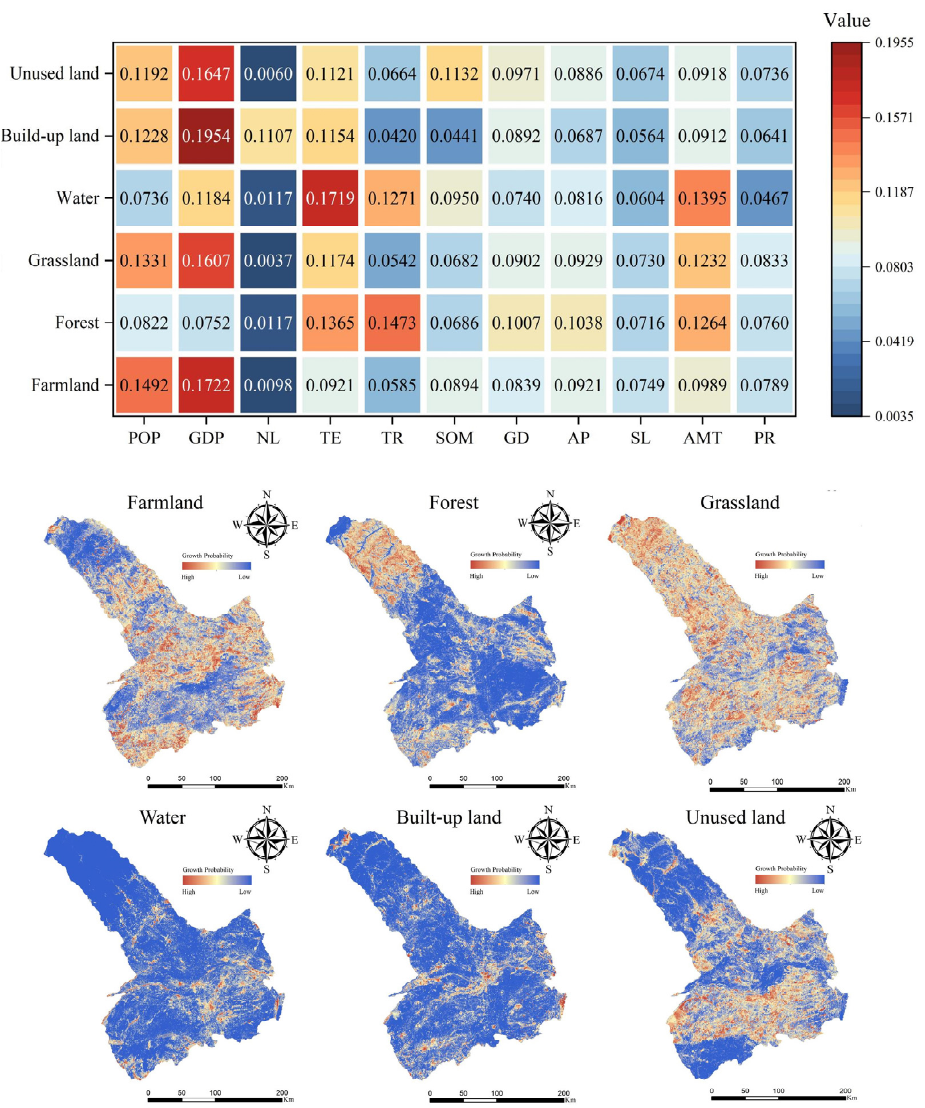
Figure 6. The contributions of the driving factors and the growth probabilities of all LULC types.